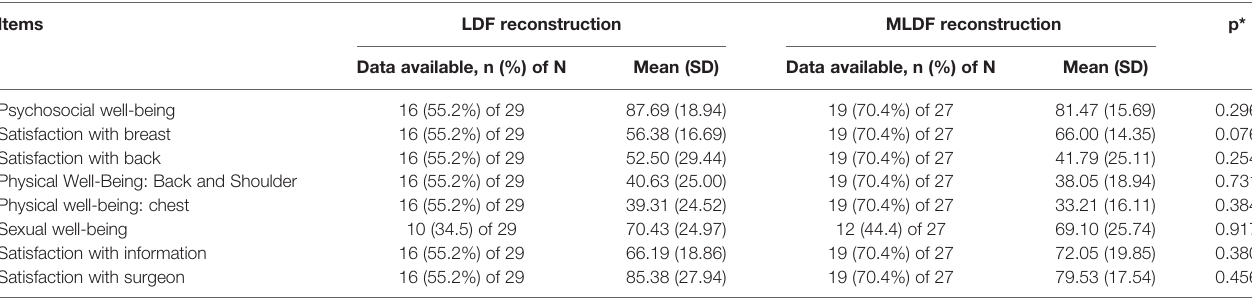
TABLE 2 | Postoperative scales of BREAST-Q Version 2.0 between LDF and MLDF breast